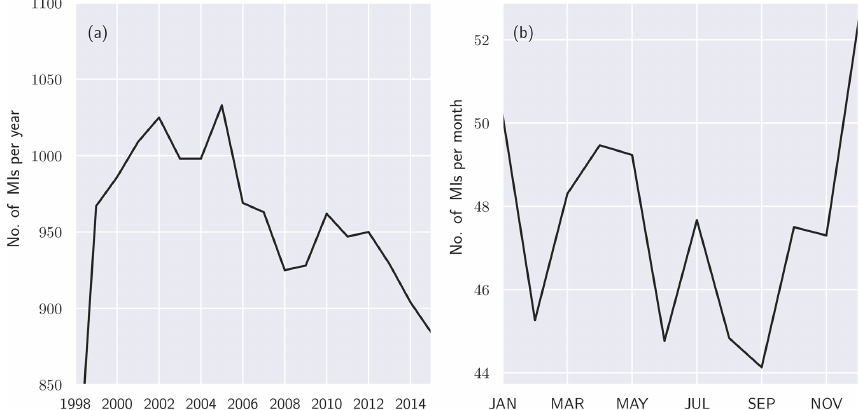
Figure 1. Number of annual MIs (a) and mean annual cycle (b) in people aged under 75 from 1985 to 2015 for the study region (city of Augsburg and counties Aichach-Friedberg and Augsburg).